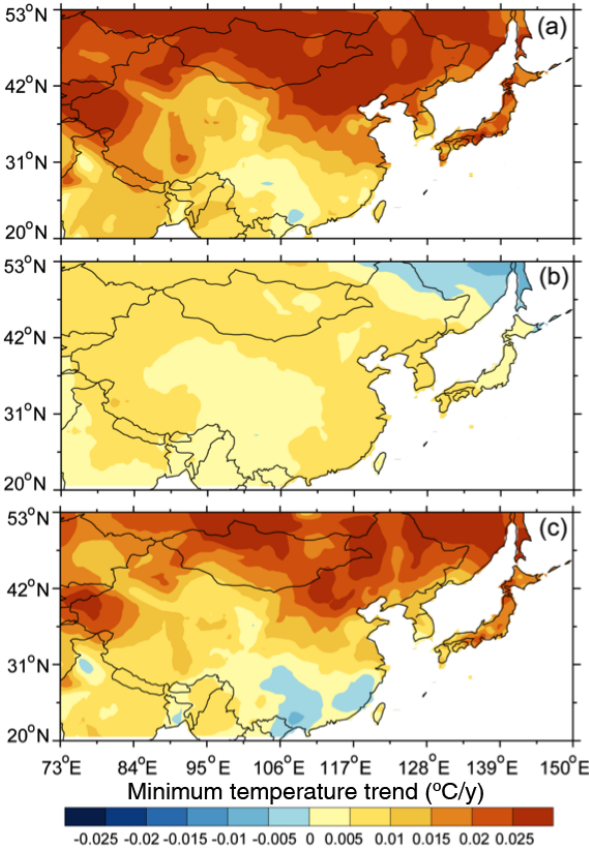
Figure 7. Same as Fig. 3, except for daily minimum temperatures.